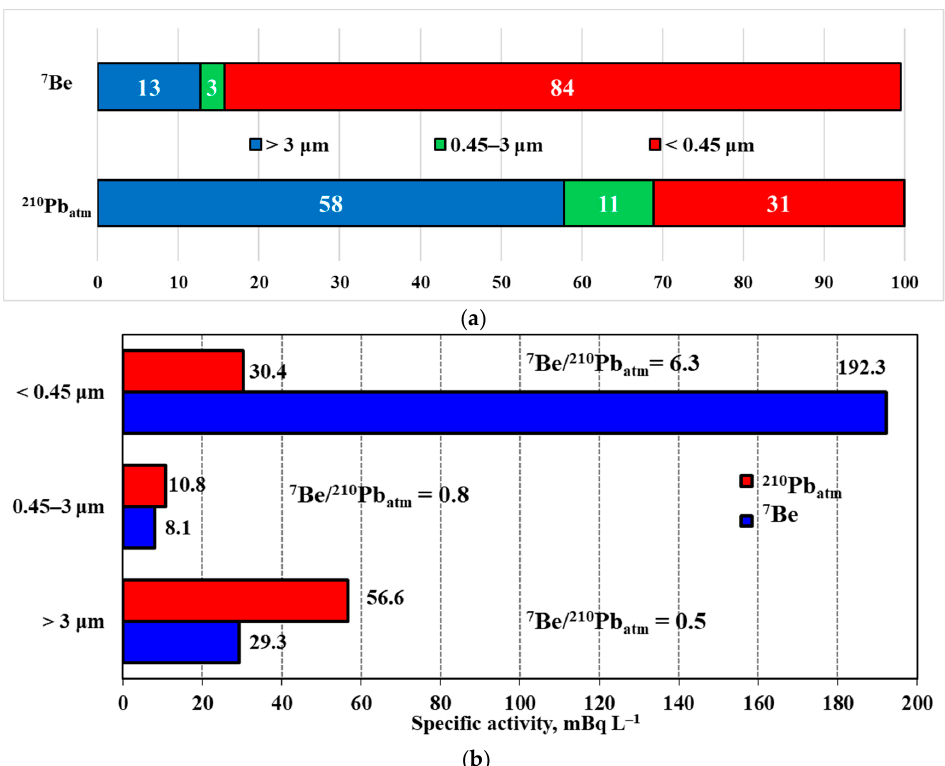
Figure 11. Averaged values of particulate fractions contribution (%) to total activity ( a ) and specific activities ( b ) of 210 Pb atm and 7 Be in suspended matter in the snow water of Group 2 samples. The distribution of 7 Be and 210 Pb atm by particulate fractions of suspended matter in snow water for Group 1 samples taken near settlements (Figure 12) differs significantly from Group 2 samples located far from settlements. In Group 1 samples, on average, only 36% of 7 Be is found in Fraction 3. This is significantly less than the 84% corresponding to Group 2. A higher contribution of coarse ‐ grained fractions to the total activity is also observed for 210 Pb atm . About 84% of this isotope is concentrated in Fractions 1 and 2. The contribution of the finely dispersed fraction decreases to 16%. The 7 Be/ 210 Pb atm ratio is indicative. The value of Fraction 3 (5.3) is close to the value (6.3) observed in